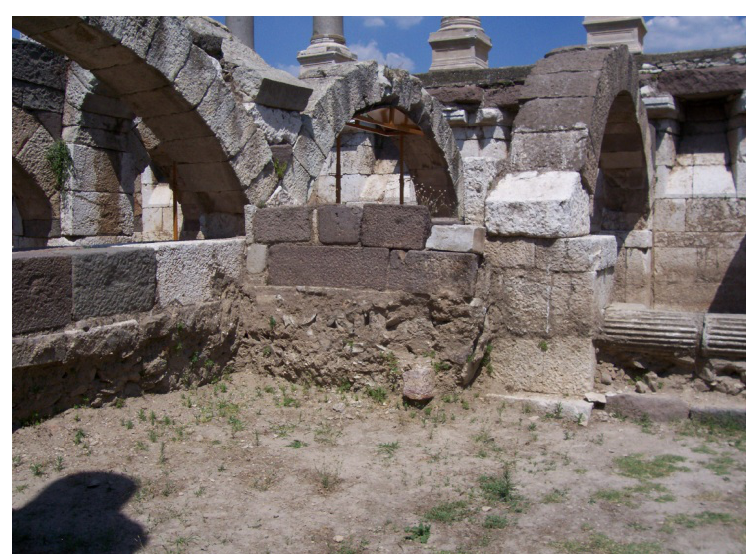
Figure 16. Cisterns under Smyrna